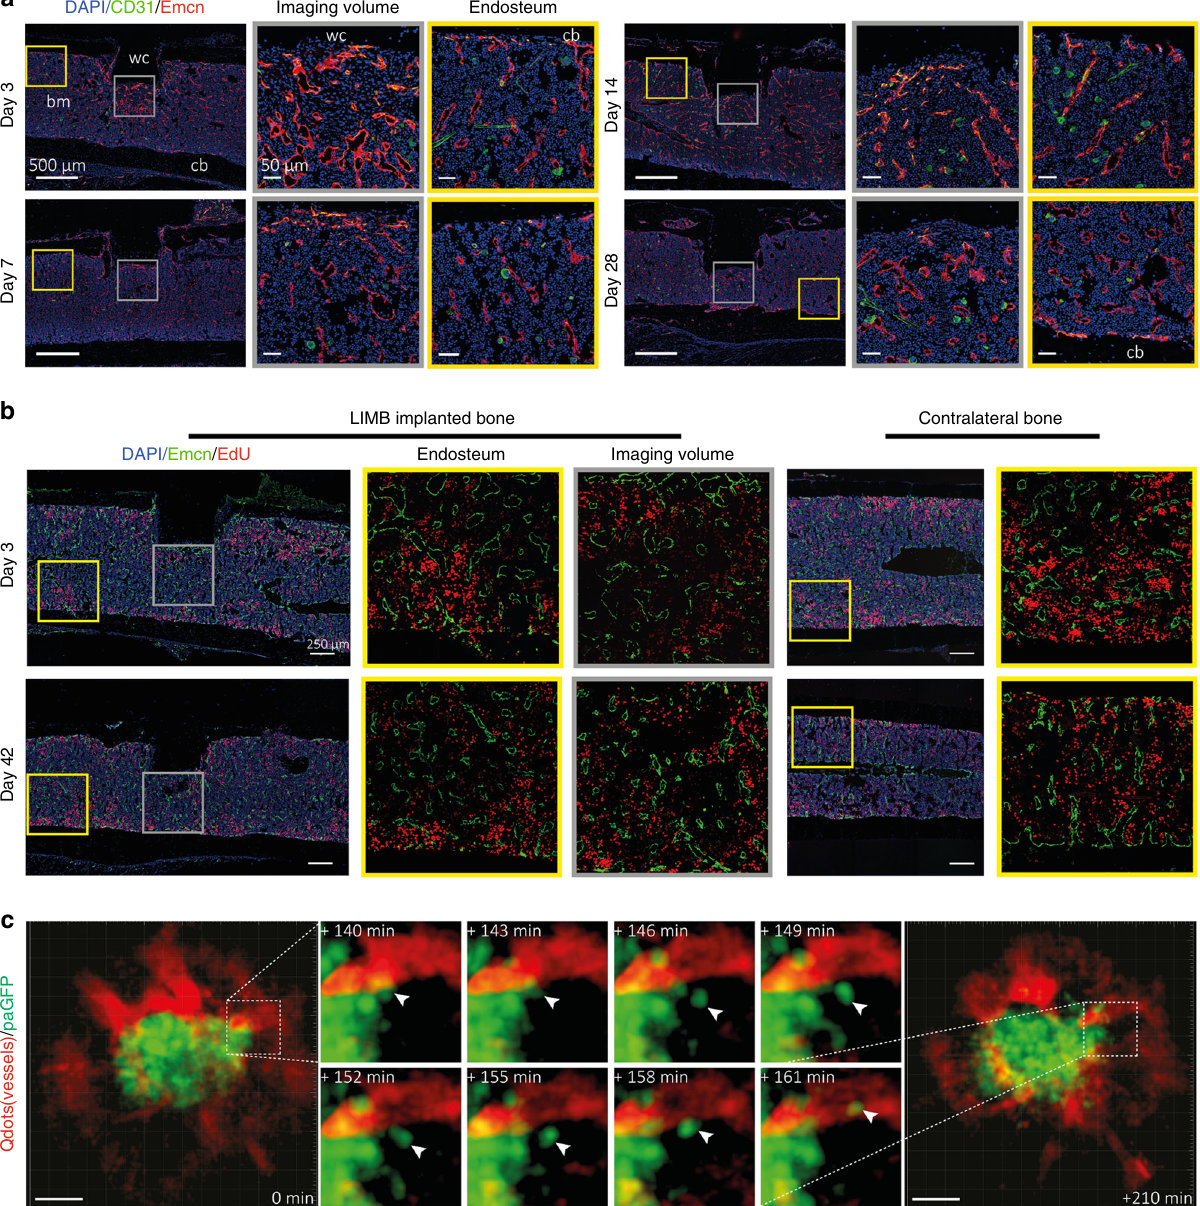
Fig. 7 LIMB and immuno fl uorescence analysis indicate possible mechanisms of vascular morphological changes deep in the femoral bone marrow, during regeneration, and in steady-state homeostasis. a Immuno fl uorescence analysis shows that type H vessels, characterized by CD31 hi Emcn hi -expressing endothelial cells, are induced and present around the implant at day 3 after LIMB implantation. Their presence may vary individually but normalizes within 28 days post-surgery. Sinusoidal and type H vessel morphology adjacent to the wc is irregular in the fi rst week and completely reorganizes to an appearance comparable to vessels found at endosteal areas distant from the injury site ( n = 3 mice). bm bone marrow, cb cortical bone. Scale bar = 500 µ m (left panels). b Immuno fl uorescence analysis after EdU pulse-chase experiments indicates similar EdU-uptake in the bone marrow of LIMB-implanted femurs and contralateral bones. Proliferating endothelial cells were rarely present at late time points after implantation. This result also supports the conclusion that 28 days after LIMB implantation both the bone and the bone marrow reach homeostasis ( n = 3 mice in each cohort). c 3D fl uorescence image (300 × 300 × 66 µ m 3 , left and right panel) acquired by LIMB 26 days post-surgery, in a paGFP mouse with the vasculature labeled by Qdots. Photoactivation was performed within a volume of 100 × 100 × 9 µ m 3 in the center of the image. The fl uorescence image was acquired 2 h post activation. Scale bar = 50 µ m. The middle panel shows time-lapse 3D images of the inset from the left panel, indicating that paGFP fl uorescent cells outside the initial photoactivation volume are present 3 h after photoactivation and that they fl uctuate in number and position within the tissue. Passive displacement of the relatively immobile stromal and vascular compartments by continuous proliferation and movement of hematopoietic cells is a possible mechanism of tissue and vascular re-localization during homeostasis (see Supplementary Movies 10,